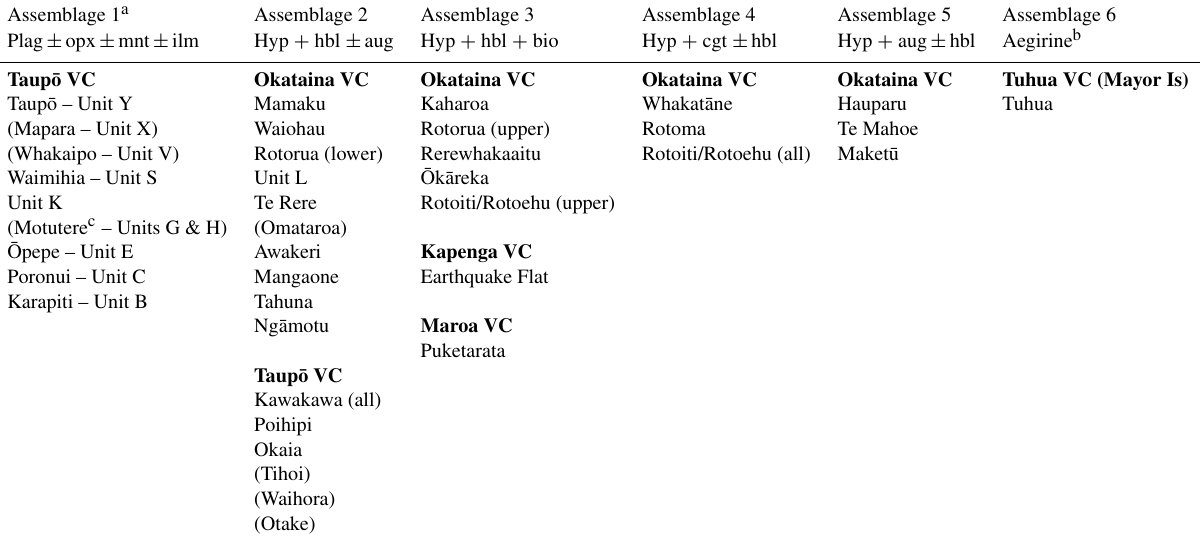
Table 5. Dominant ferromagnesian. Mineral assemblages for late Quaternary silicic tephra deposits updated from Froggatt and Lowe (1990). Plag – plagioclase feldspar; opx – orthopyroxene; mnt – magnetite; ilm – ilmenite; hyp – hypersthene; hbl – hornblende; bio – biotite; cgt – cummingtonite; aug – augite. The mineral assemblages are listed with mineral species in order of abundance; the diagnostic mineral in each assemblage is in bold. Tephras are listed multiple times if their mineral assemblage changes through the eruption sequence, and deposits in brackets are not included in the TephraNZ